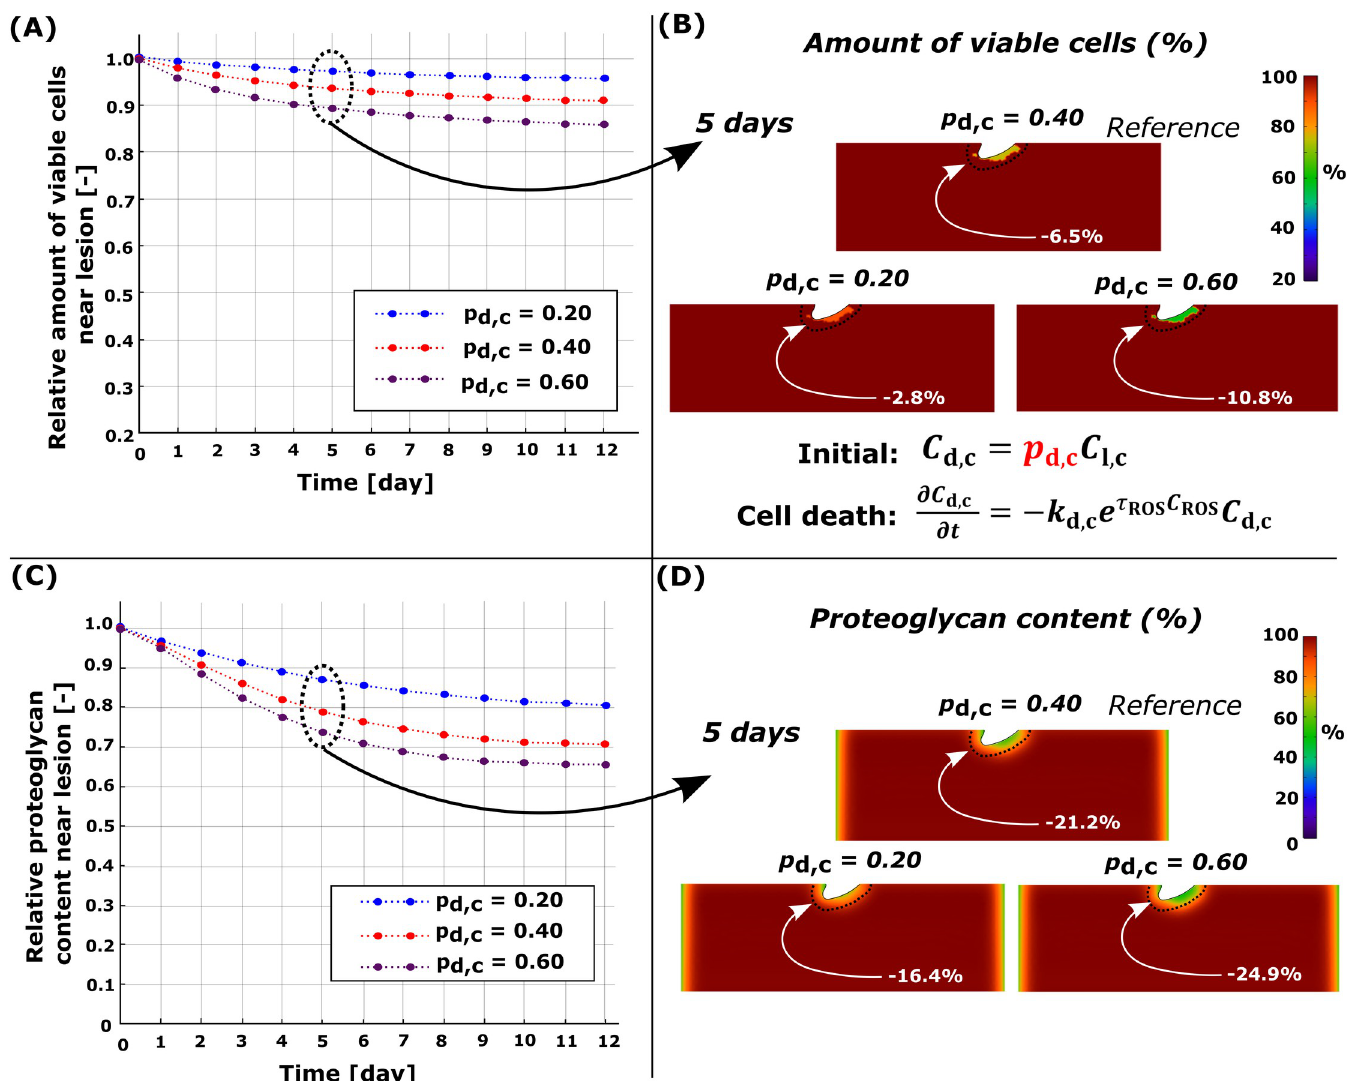
Fig 6. Sensitivity analysis for simulated damaged cell rate p d,c . Comparison of temporal and spatial changes at day 5 (A)-(B) in cell viability and (C)-(D) in proteoglycan (PG) content. (A) Higher number of damaged cells led to more cell death and (C) more intensive PG degeneration near the cartilage lesion. Red line in (A) and (B) refers to the reference model ( p d,c =